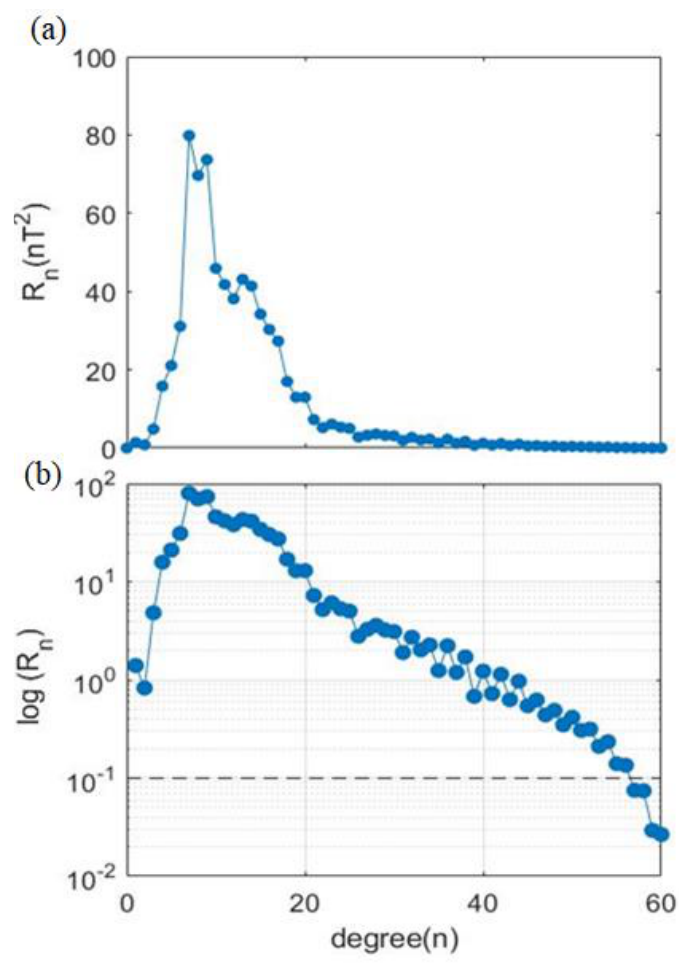
Figure 4. The power spectrum of the model with respect to the degree ( n ), ( a ) in a linear scale and ( b ) in a logarithmic scale.